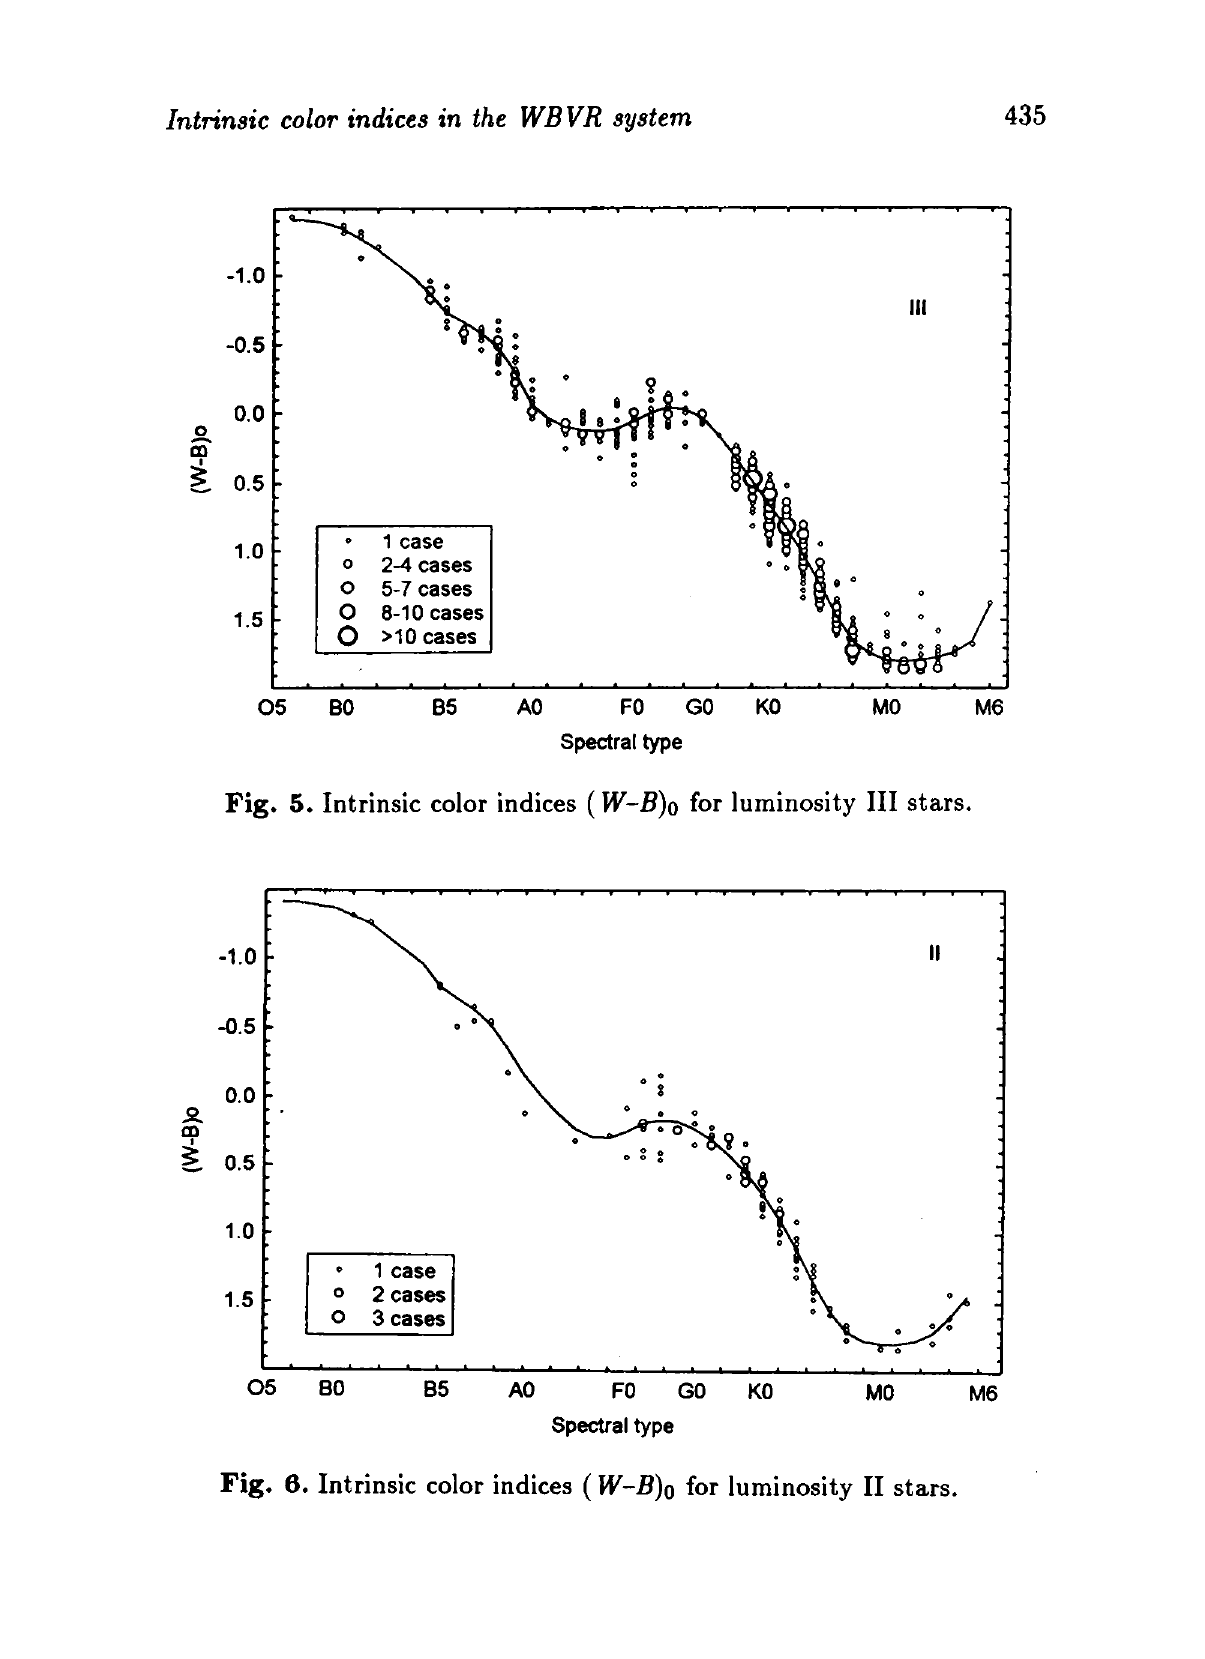
Fig. β. Intrinsic color indices ( W-B)